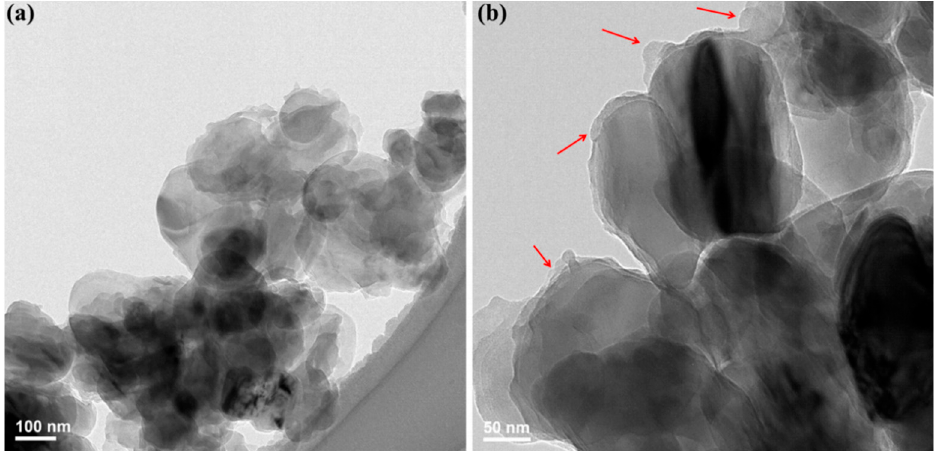
Figure 3. TEM images of ( a ) and ( b ) h-BN@(PDA +